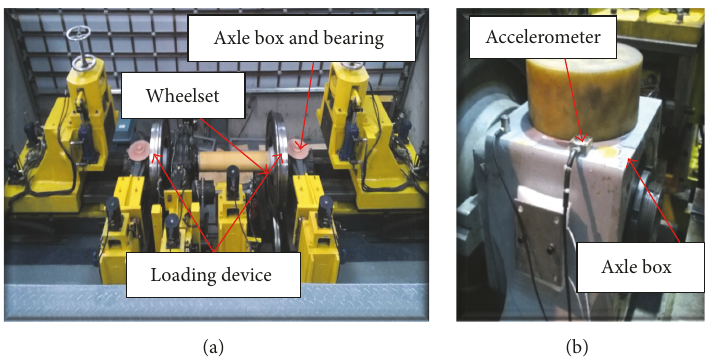
Figure 10: Photos of the test bench and measurement sensor.